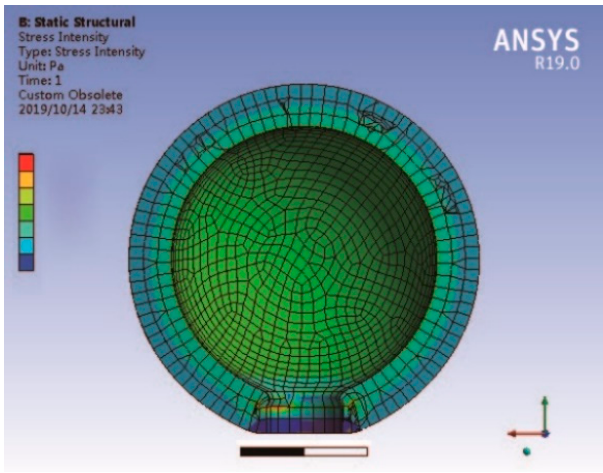
Figure 26. Spherical pressure hydrophone.